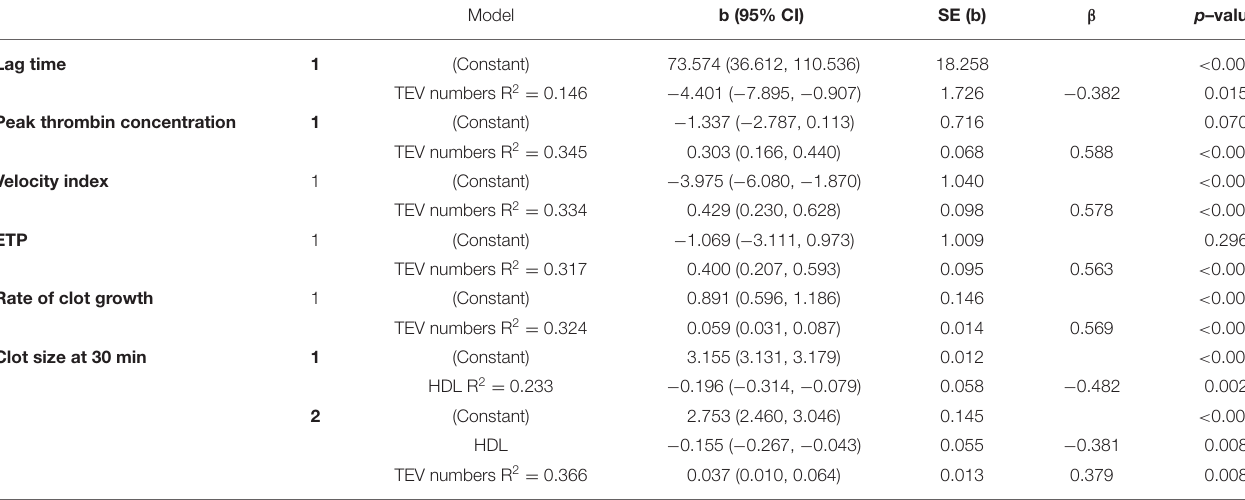
TABLE 5 | Independent predictors of thrombogenic risk markers determined by stepwise regression. Model b (95% CI) SE (b) β p –value